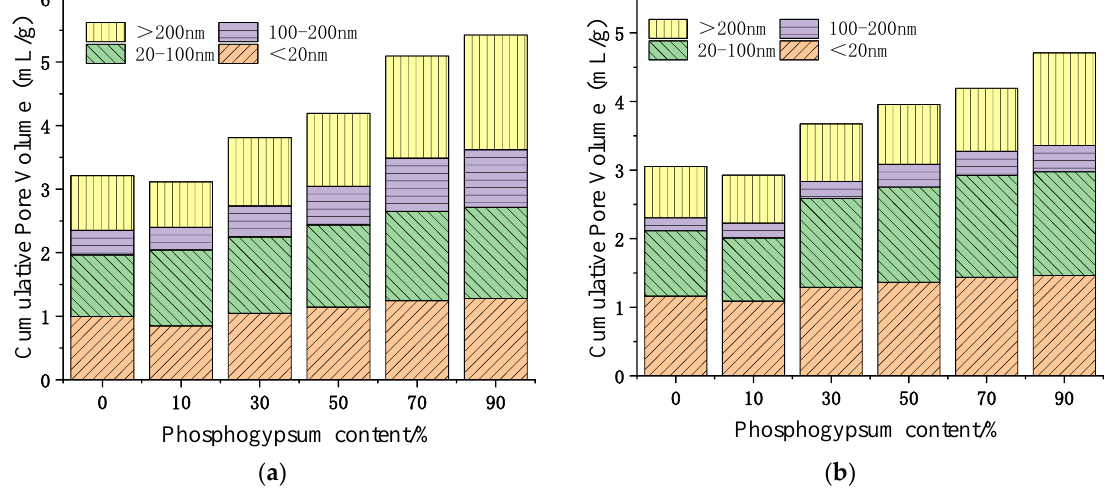
Figure 5. Pore size distributions of composite cementitious material: ( a ) 3 days; ( b ) 28 days.